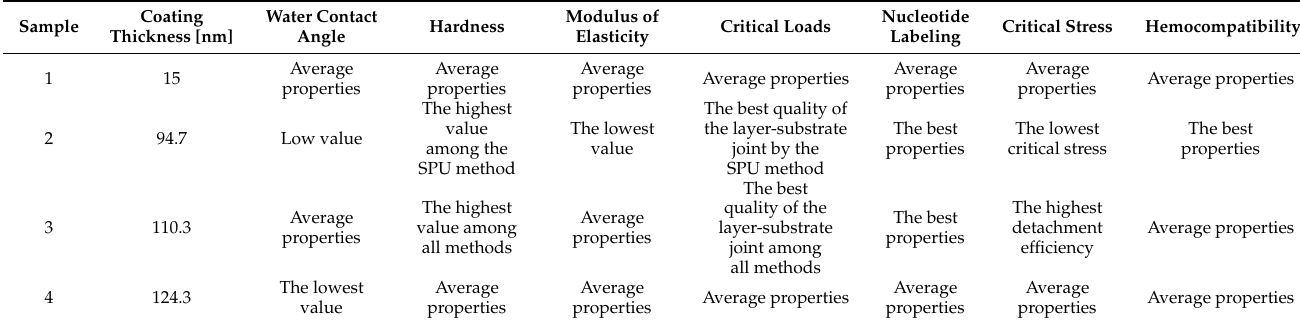
Table 3. Comparative analysis of tested